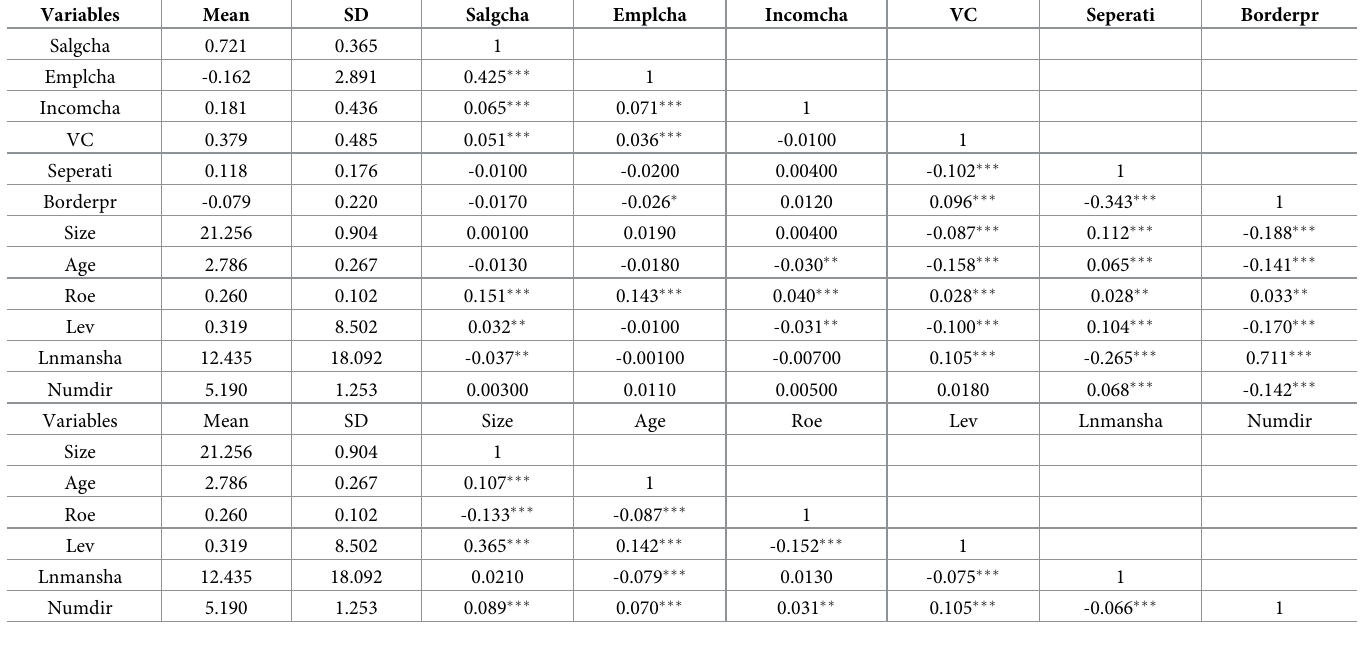
Table 1. Descriptive statistics and correlation